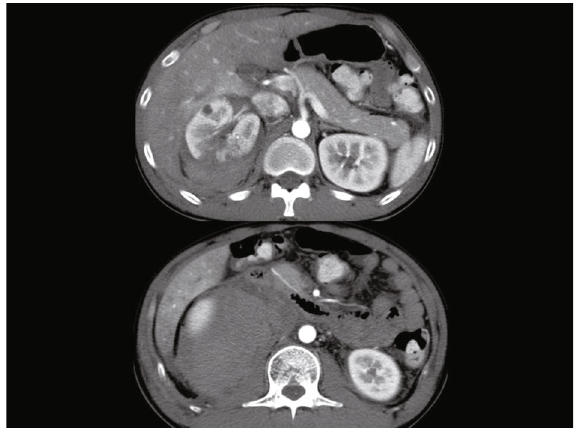
Figure 1: Enhanced abdominal computed tomography (CT) on arrival. CT showed extravasation of contrast medium from the injured right kidney. An accompanying massive retroperitoneal hematoma had pushed up the visceral organs into the ventral side. Table 1: Blood test fi ndings on arrival.